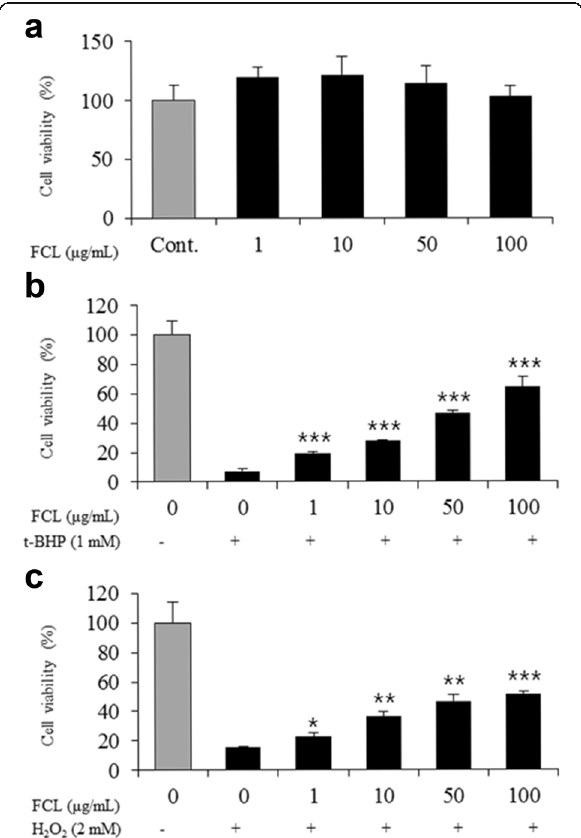
Fig. 1 Protective effects of FCL against oxidative stress in C6 cells. Effects on the cell damage induced by t-BHP ( b ) and H 2 O 2 ( c ) were measured by the MTT assay. Cells were treated with t-BHP (1 mM) for 1 h or H 2 O 2 (2 mM) for 30 min after the incubated with FCL for 15 h. Data represent means ± SEM of three independent experiments. * P < 0.05 ** P < 0.01 as compared with the t-BHP- or H 2 O 2 -treated